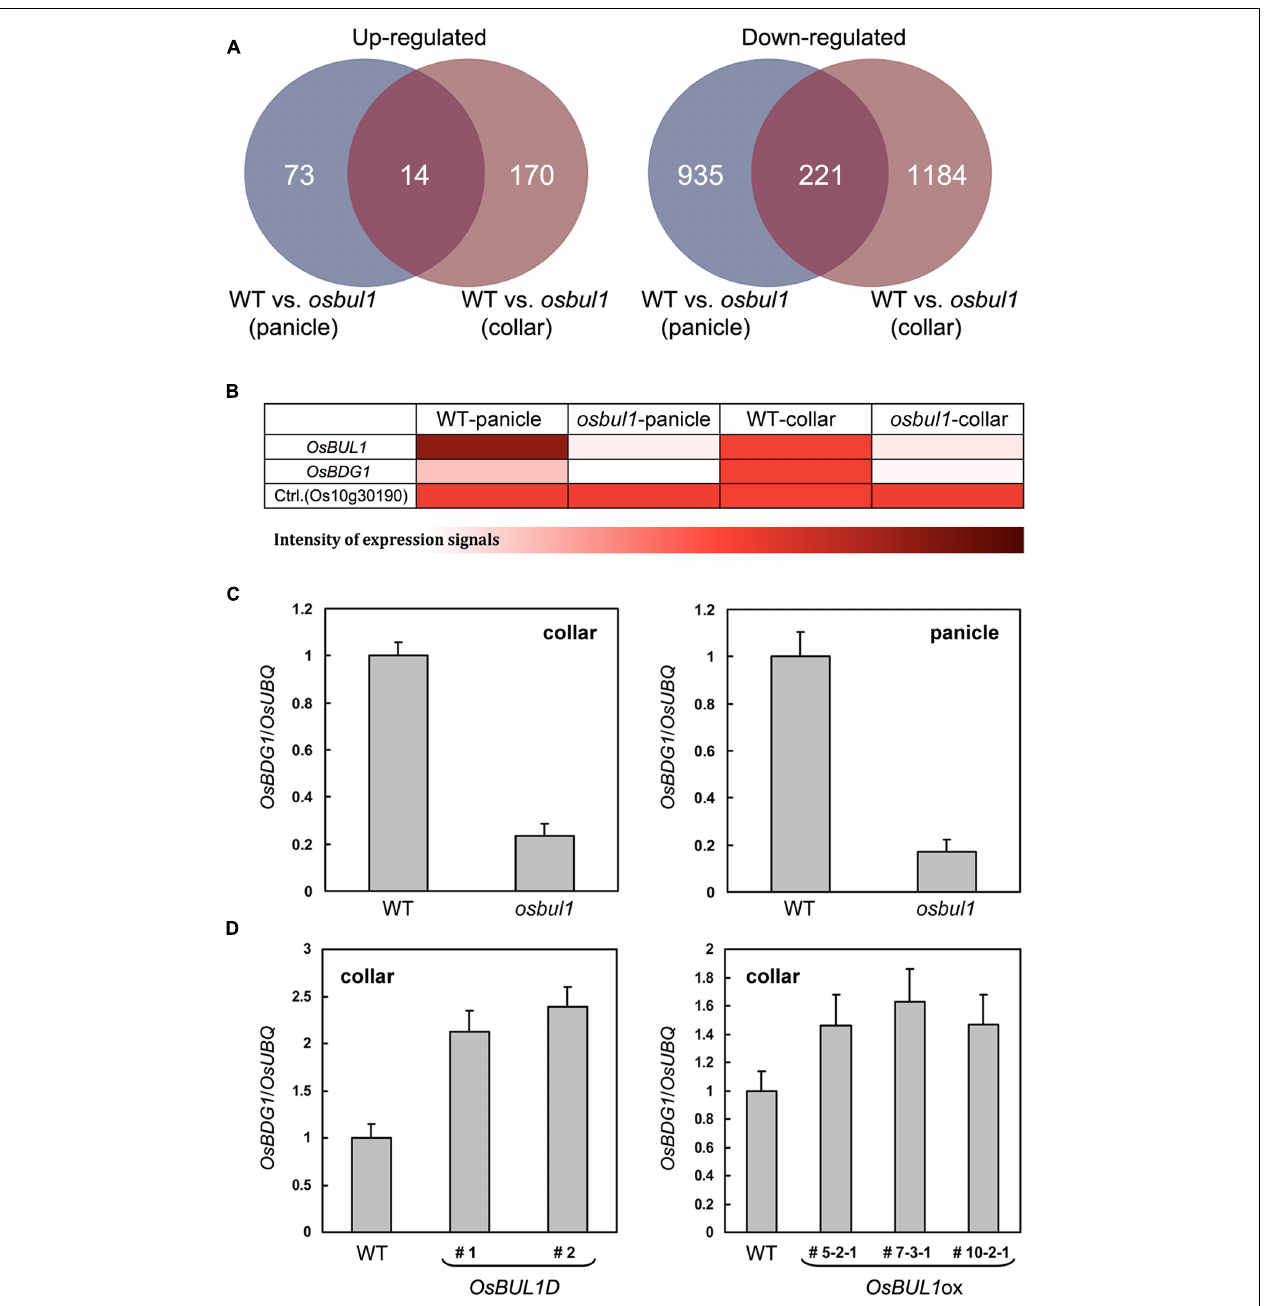
FIGURE 1 | OsBDG1 is a putative downstream gene of OsBUL1 in expression. (A) Venn diagrams for upregulated and downregulated genes in the panicle and collar of osbul1 . (B) A heat map based on microarray hybridization results shows that OsBDG1 expression is reduced in osbul1 . Color scale represents log signal values and Os10g30190 is a control showing similar signal values in the microarray hybridization between WT and osbul1 . (C) Quantitative RT-PCR confirmed the reduced expression of OsBDG1 in osbul1 in collars and panicles. Conversely, expression level of OsBDG1 is higher in an OsBUL1 activation tagging line, OsBUL1D (Jang et al., 2017) and OsBUL1 overexpressors (ox) than in the WT (D) . Data are the average of three or four independent experiments and normalized by OsUBQ . Error bars indicate SD.